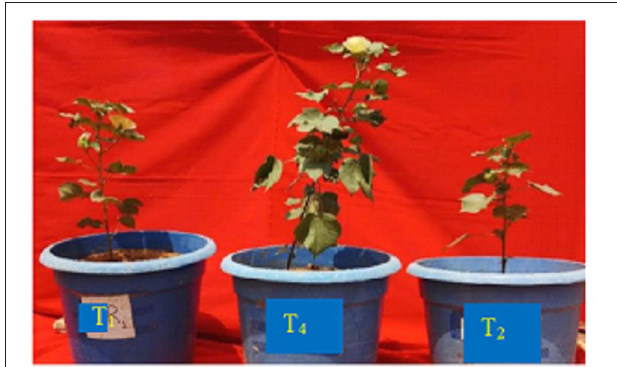
FIGURE 3 | Growth promoting by phyllosphere bacteria in cotton. A significant increase in plant height with the inoculation of CPB-24 was recorded in cotton crops under imposed drought